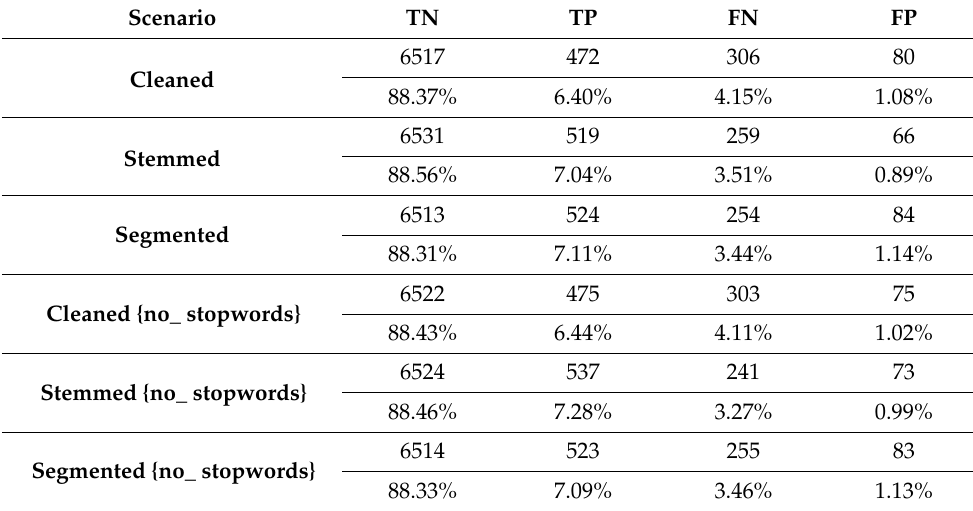
Table 3. The confusion matrix of the SVM